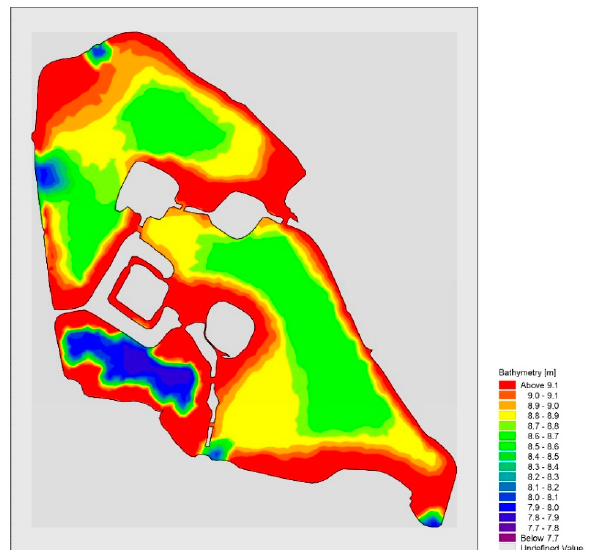
Figure 3. Xuanwu Lake model terrain elevation.